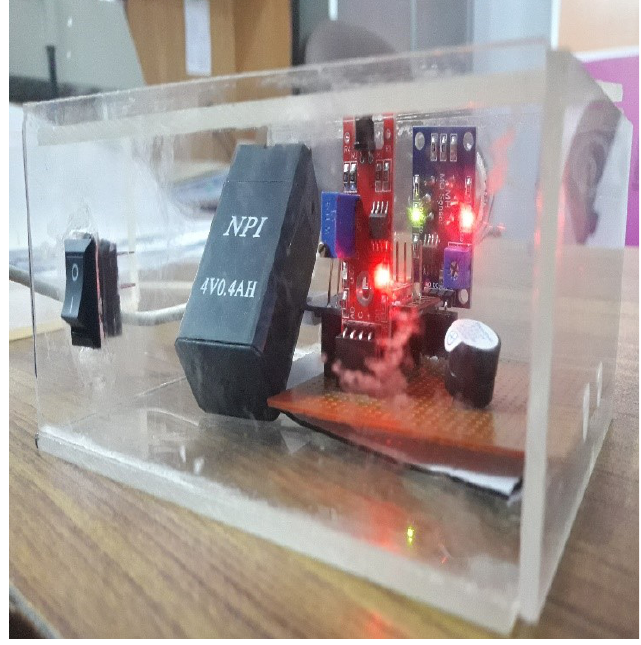
Figure 5. Implementation of the fire detection